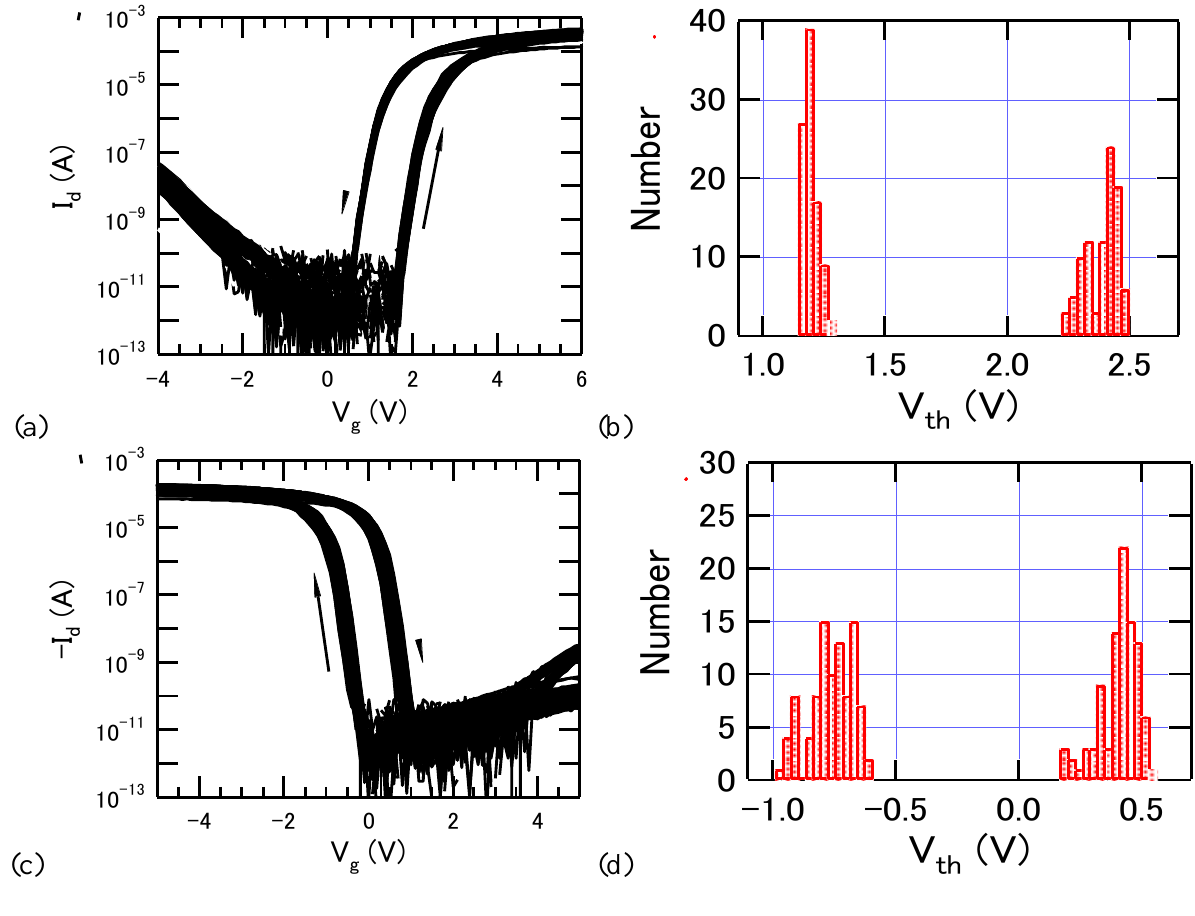
Figure 8. (a) Drain current-gate voltage curves of 94 n -channel Pt/SBT/Hf-Al-O/Si FeFETs and (b) V distribution of the 94 n -channel FeFETs; (c) Drain current-gate voltage th curves of 95 p -channel Pt/SBT/Hf-Al-O/Si FeFETs and (d) V distribution of the 95 th p -channel FeFETs. Thicknesses of the SBT and Hf-Al-O were 400 nm and 7 nm. Reprinted from reference [32] with permission of IOP Publishing